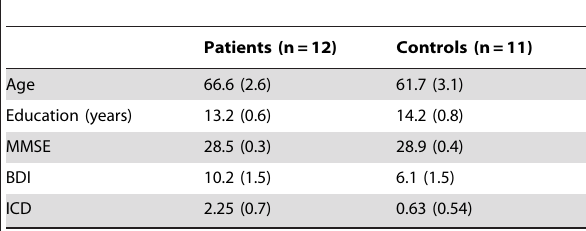
Table 1. Neuropsychological data